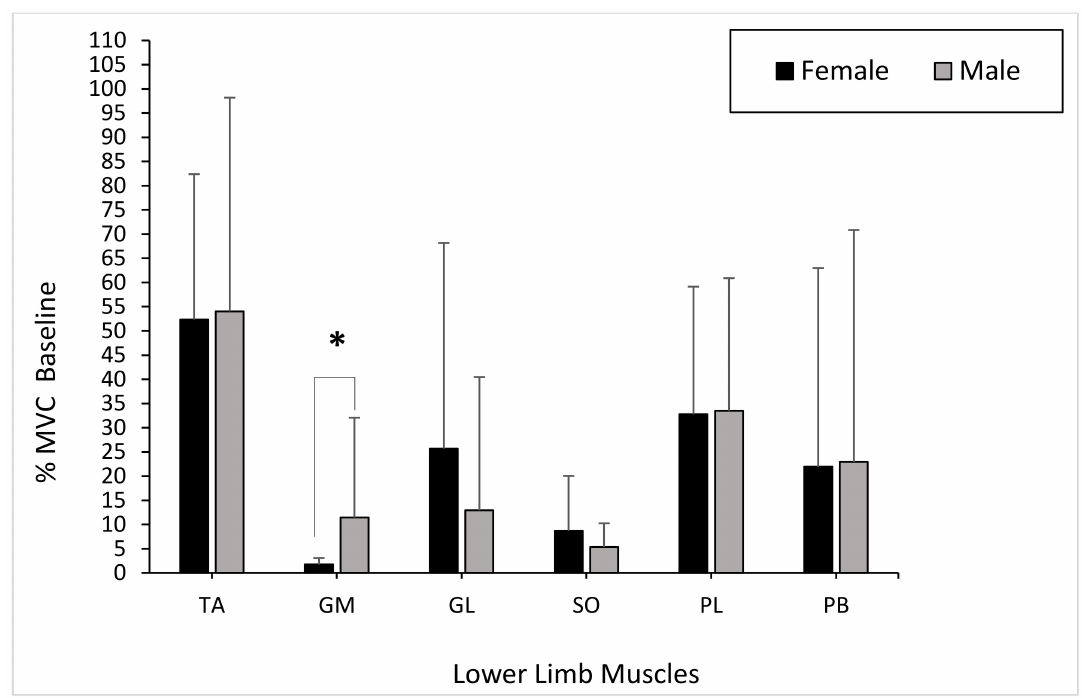
Figure 3. Mean gender differences in muscle activation (gastrocnemius medialis (GM), gastrocnemius lateralis (GL), soleus (SO), tibialis anterior (TA), peroneus longus (PL), and peroneus brevis (PB)) within the dominant limb during the baseline phase with error bars ( ± standard deviation; * statistical significance).